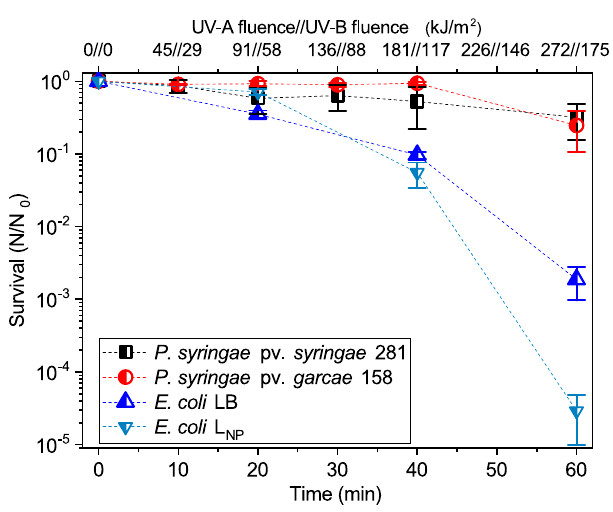
Figure 5. Survival curves to “environmental” UV radiation (UV-A + UV-B). For this more accurate representation of the solar UV found in the troposphere, P. syringae pv. syringae 281 and P. syringae pv. garcae 158 suffered a decrease in viability of less than 90% after 60 minutes of exposure, from an initial population of ~5 × 10 6 cells/ml. Meanwhile, LB-grown E. coli presented a 1,000-fold reduction in survival from its initial numbers of ~5 × 10 7 cells/ml. When grown in L NP , the minimal medium used for the P. syringae strains, E. coli was even more sensitive, with a drop in viability after the full exposures of almost 5 logs (from about 10 7 cells/ml in this case). Error bars denote standard deviations of the means (n =